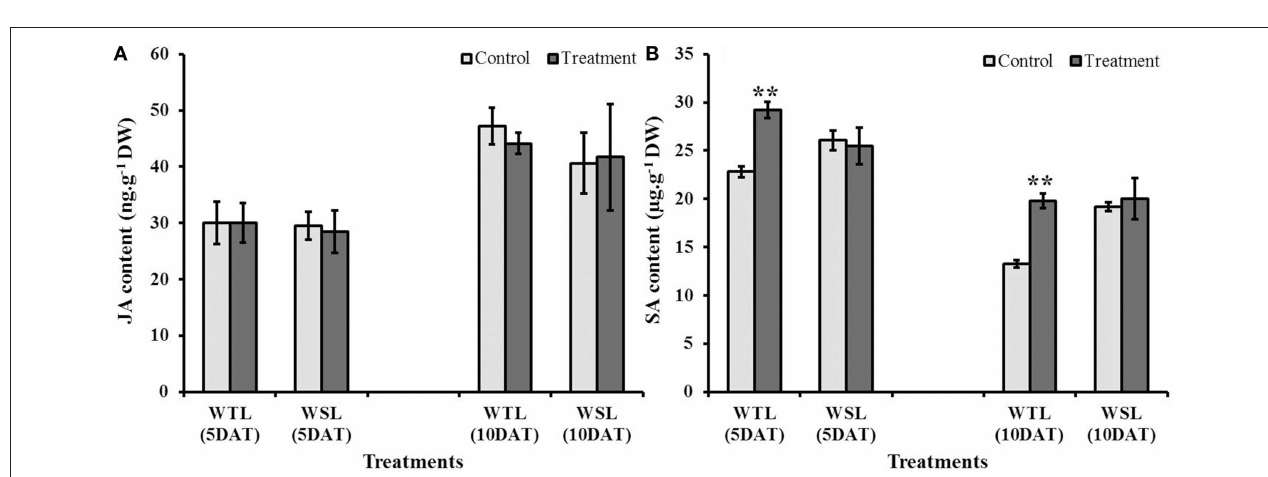
FIGURE 6 | Endogenous jasmonic acid (JA) (A) and salicylic acid (SA) (B) contents in two soybean lines after waterlogging treatment. In the figures, WTL indicates the waterlogging tolerant line (PI408105A) and WSL denotes the waterlogging susceptible line (S99-2281). In the figure, star marks indicate a significant difference between control and treatment at P < 0 . 05 or P < 0 . 01 . Data is the average ± standard error ( n = 3 ).